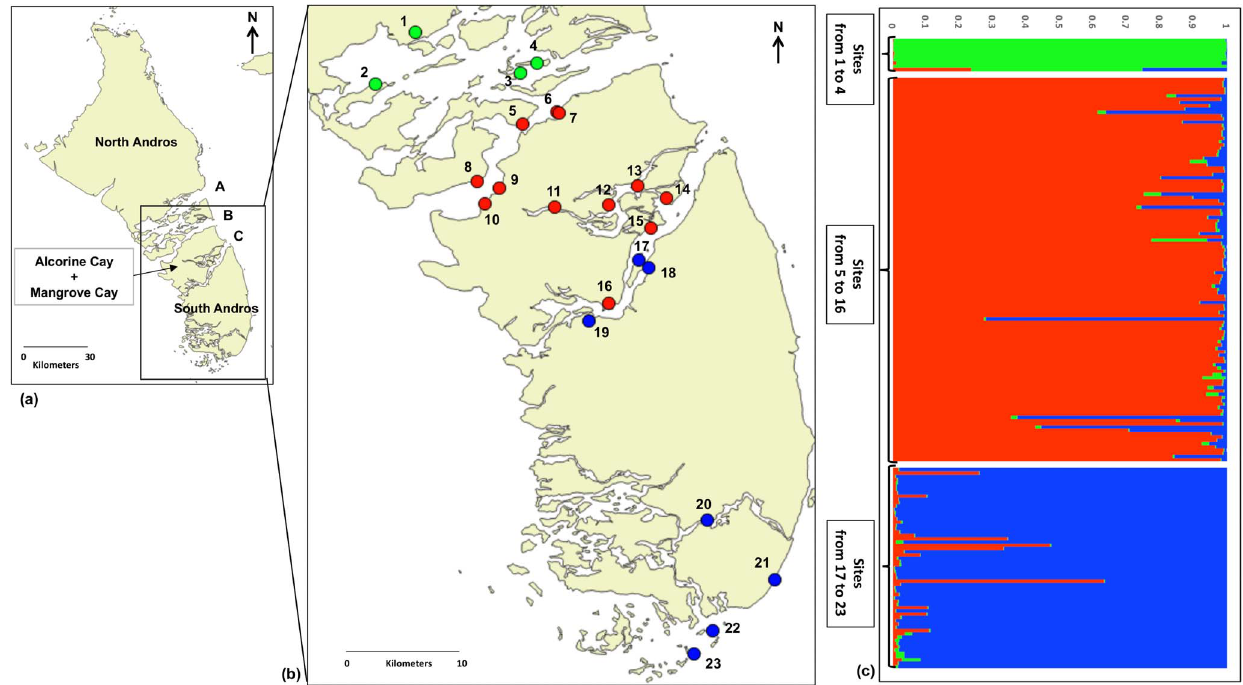
Figure 1. Map of Andros Island depicting its four major landmasses, the sampling locations and the assignment test results. ( a ) North Andros, Alcorine Cay, Mangrove Cay and South Andros. A, B and C indicate North, Middle and South bight respectively (the map is not resolved enough to depict the separation of Mangrove and Alcorine Cays by Lisbon creek); ( b ) A map of the 23 sampling locations (see Table 1 for details on each location). Sampling sites are colored according to the predominant assignment of individuals to one of three populations given the result of the STRUCTURE analysis; ( c ) Bayesian clustering output.